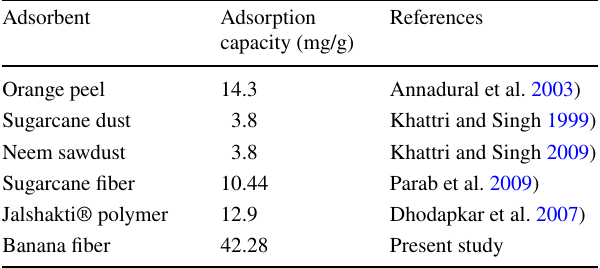
Table 5 Comparison of different low-cost adsorbents based on